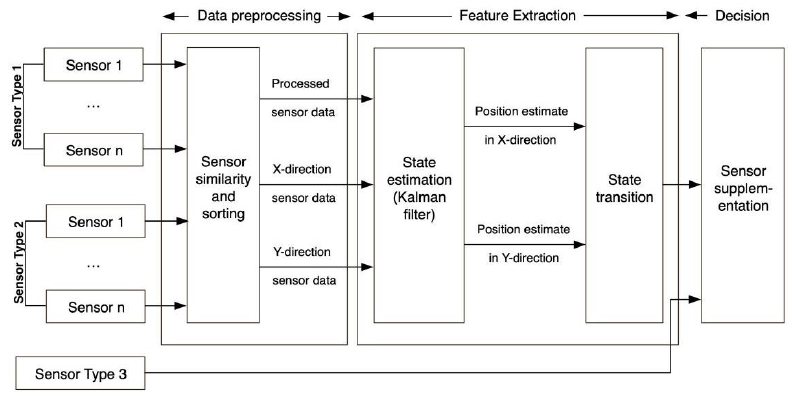
Figure 11. Complementary system block diagram.